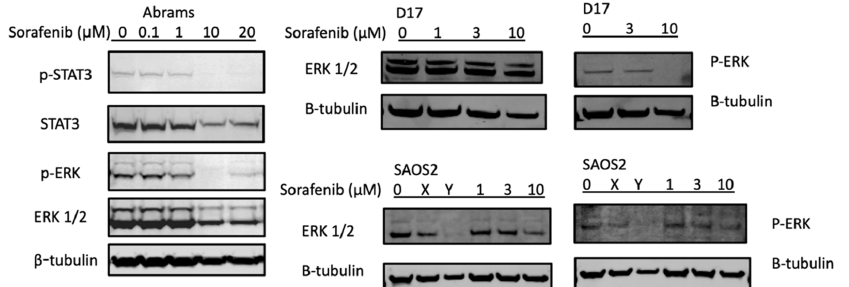
Figure 3. Sorafenib decreases expression of p-STAT3 and p-ERK in protein analysis. Canine osteosarcoma Abrams cells were treated with either DMSO (control) or various concentrations of sorafenib (0.1, 1, 10, 20 μM) for 24 h then subjected to Western blot analysis. -actin and -tubulin were used as loading controls. X: JQ1 0.1 μM, Y: bortezomib 25 nM.